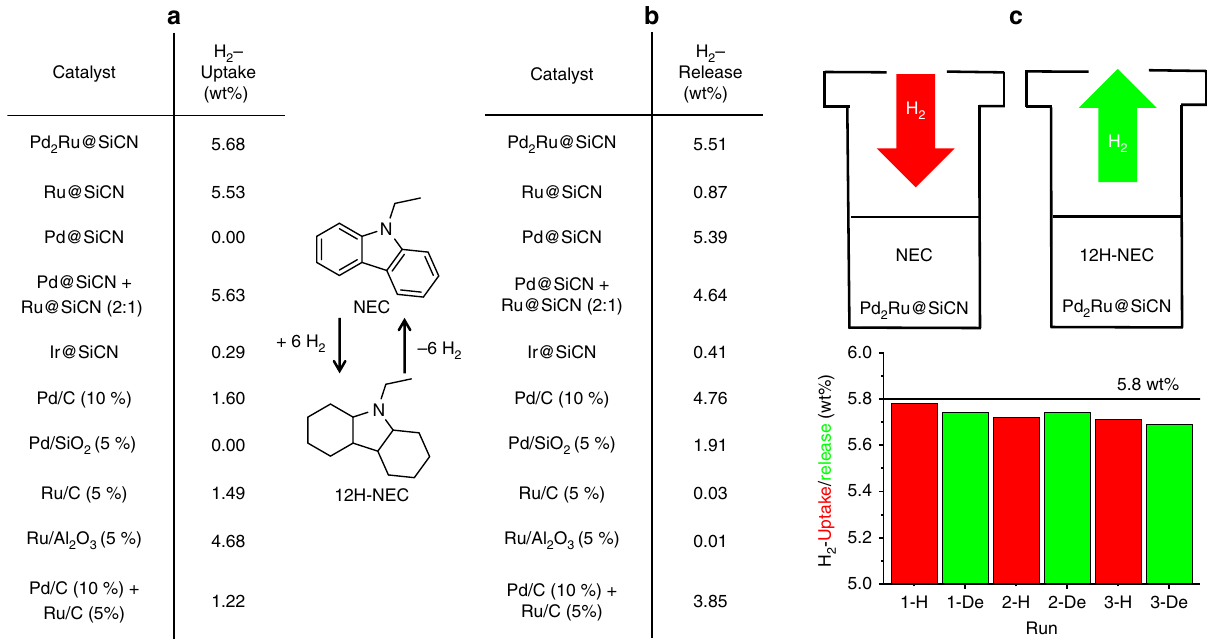
Figure 2 | Catalyst screening and reversible hydrogen storage in NEC. ( a ) Hydrogenation of NEC to 12H-NEC; 110 (cid:2) C, p(H 2 ) ¼ 20bar, 1mmol NEC, 0.52mol% active metal, 36h. ( b ) Dehydrogenation of 12H-NEC to NEC; 180 (cid:2) C, 2mmol 12H-NEC, 0.52mol% active metal, 7h. The hydrogen uptake and release values were calculated by gas chromatography (GC) and GC-mass spectrometry (MS) analysis. The maximum hydrogen uptake or release is 5.8wt% (calculated based on the substrate). ( c ) Catalyst reusability and reversible hydrogen storage in NEC: 1.0g (5.12mmol) N -ethylcarbazole, 200mg Pd 2 Ru@SiCN (0.52mol% active metal); hydrogenation: 110 (cid:2) C, 20bar H 2 , 36h; dehydrogenation: 180 (cid:2) C, 20h. The hydrogen uptake and release values were calculated by GC and GC-MS analysis and based on the preceding step.